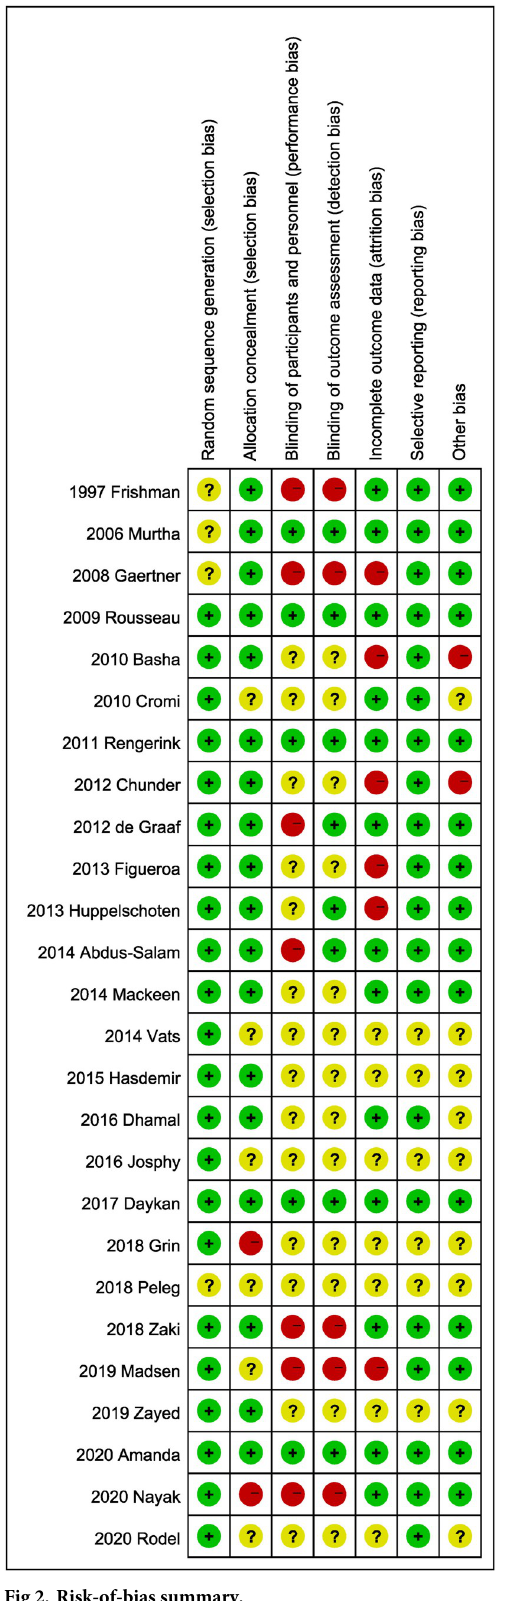
Fig 2. Risk-of-bias